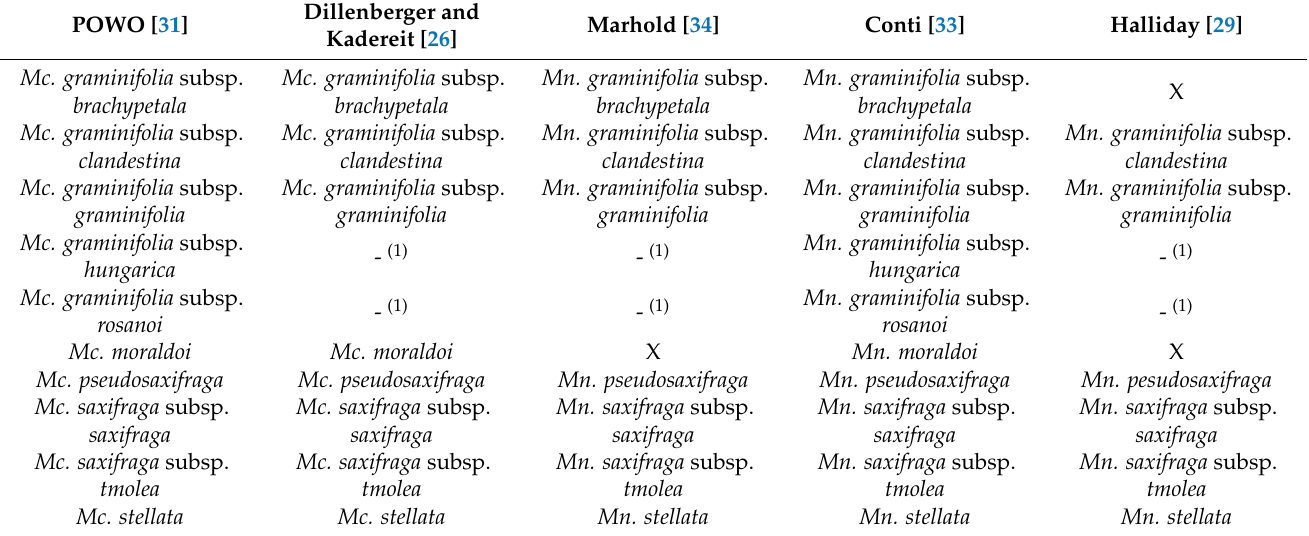
Table 1. Synopsis of the most comprehensive treatments of Mcneillia [abbr. “ Mc. ”]/ Minuartia sect. Lanceolatae ser. Graminifoliae [abbr. “ Mn. ”]. Authorships omitted for the sake of brevity. Legend: